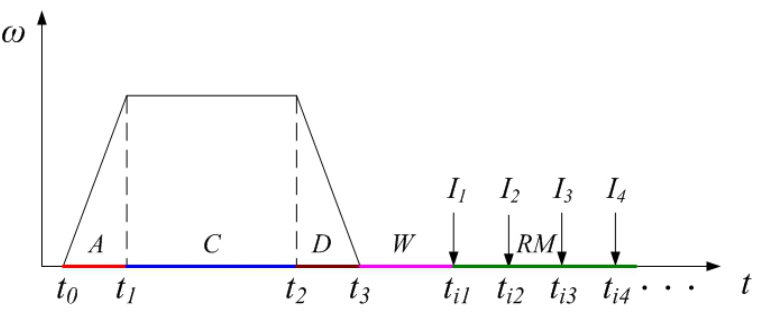
Figure 7. Improved spin/stop technique of the servo